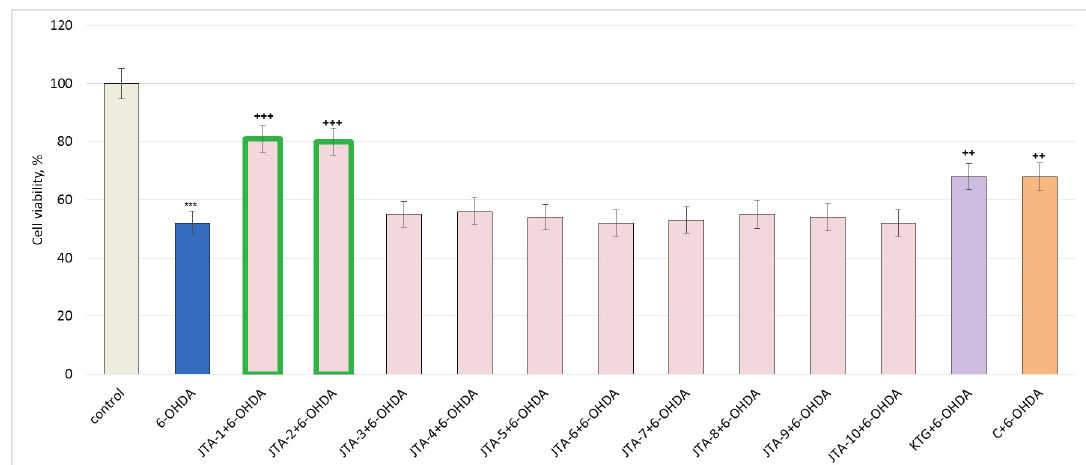
FIGURE 3 - Effects of JTA-1 to JTA-10, in conditions of 6-OHDA-induced oxidative stress, on SH-SY5Y cell viability, measured by MTT-test. After 24 h of treatment with test substances and toxic agent, cell viability is expressed as a percentage of a control (non-treated cells). Mean ± SEM (n = 6). *** P < 0.001 – vs control; ++ P < 0.01; +++ P < 0.001 – vs